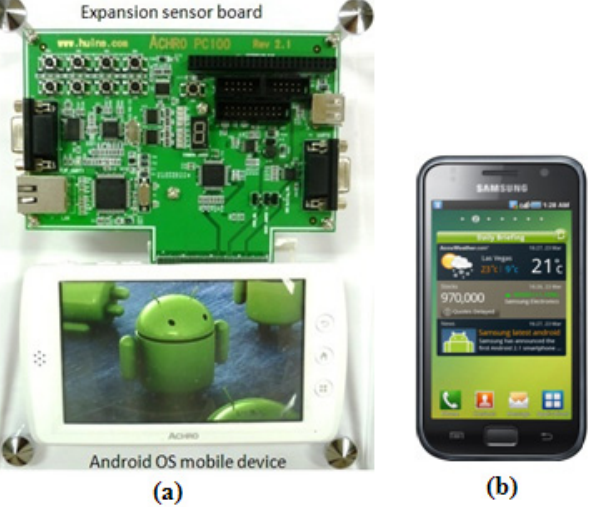
Figure 6. Android™ mobile devices: ( a ) AchroHD (Huins Inc. Korea); ( b ) Galaxy S (Samsung Electronics Ltd.,